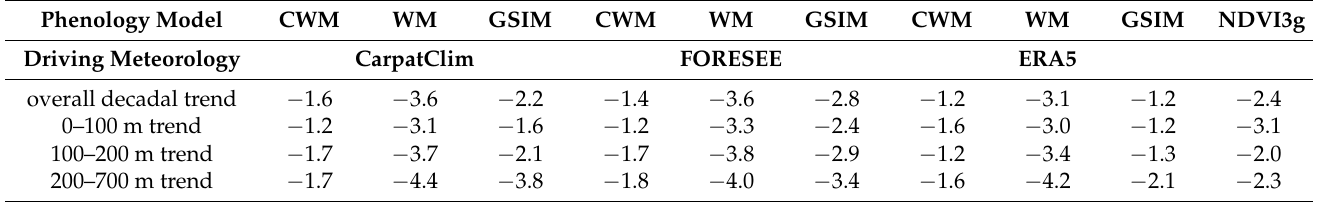
Table 4. Long-term change in country-median SOS (expressed as days/10 years) predicted by different model–database combinations, and the NDVI3g-based observation median for the 1982–2010